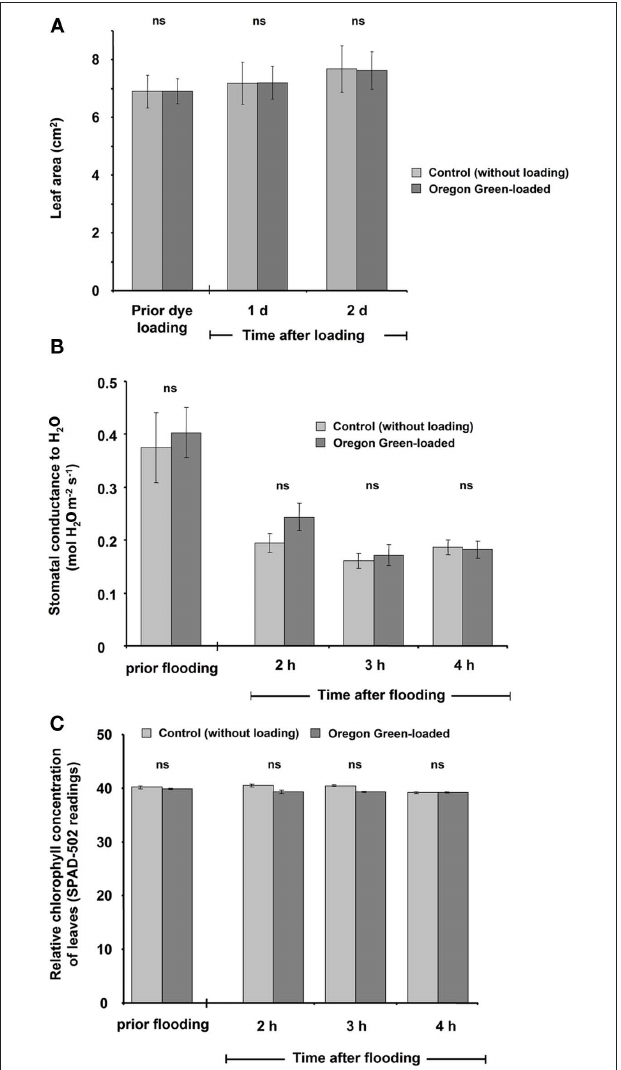
Figure 9 | Leaf growth (A), stomatal conductance (B), and relative chlorophyll concentration (C) as influenced by the dye and the loading procedure. To test whether these parameters were affected, a paripinnate leaf was used. One leaflet was loaded with the dye, whereas the second was not loaded with the dye and was used as control. Leaves were tested (A) prior to loading and at 1 and 2 days after loading or (B,C) prior to loading and 2, 3, and 4 h after loading. The parameters were not influenced by the presence of the dye or the loading procedure. The data are mean of four biological replicates gained from independent experiments ± SE. Paired t -test revealed no significant (ns) mean differences at p